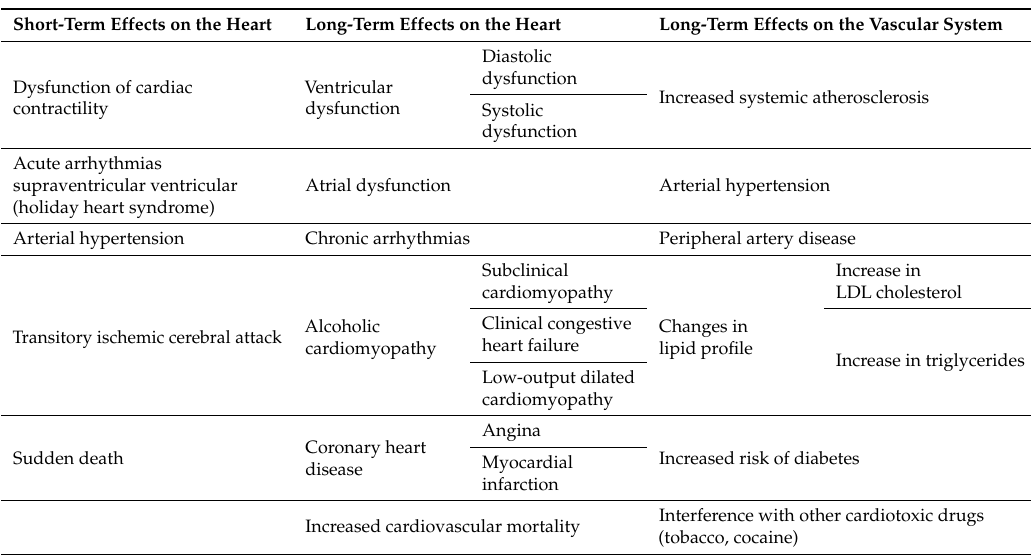
Table 2. The effects of high-dose alcohol on short and long-term cardiovascular